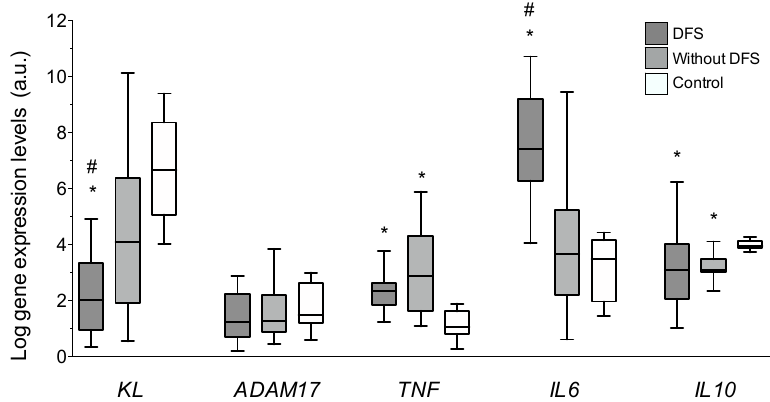
Figure 3. Gene expression levels of KL , ADAM17 (A Disintegrin and A Metalloproteinase 17), TNF (tumor necrosis factor α ), IL6 (interleukin 6), and IL10 determined by quantitative RT-PCR in vascular walls of patients with diabetic foot syndrome (DFS), without DFS, and controls. * p < 0.01 vs. control group; # p < 0.05 vs. patients without DFS.